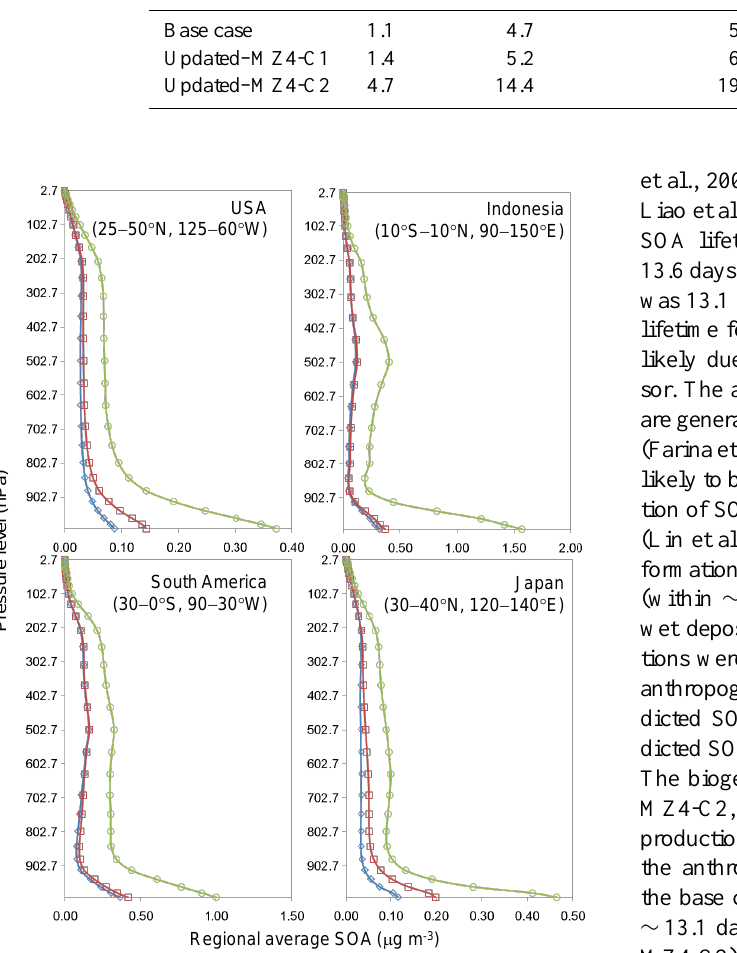
Fig. 5. Vertical distributions of regionally-averaged annual SOA concentrations (µg m -3 ). Simulated SOA concentrations for the base-case are represented by open diamonds (blue); open squares (red) represent updated version, MZ4-C1 (updated 2p parameters), and open circles (green) represent updated version, MZ4-C2 (updated 2p parameters and additional parent VOCs).